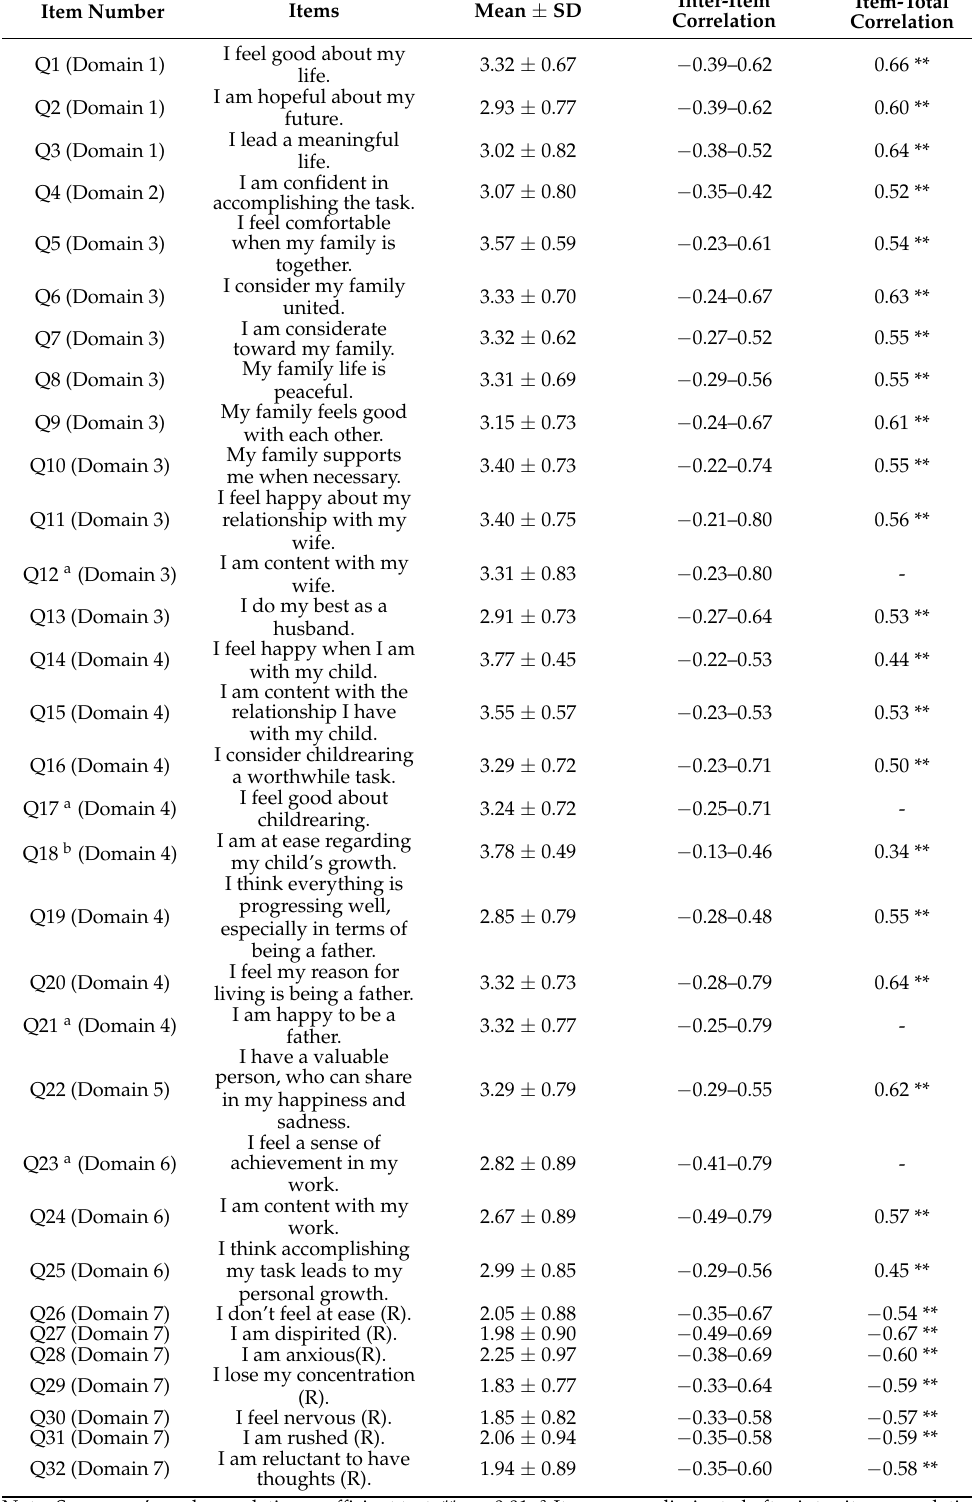
Table 2. Item analysis of the MSCF (N =